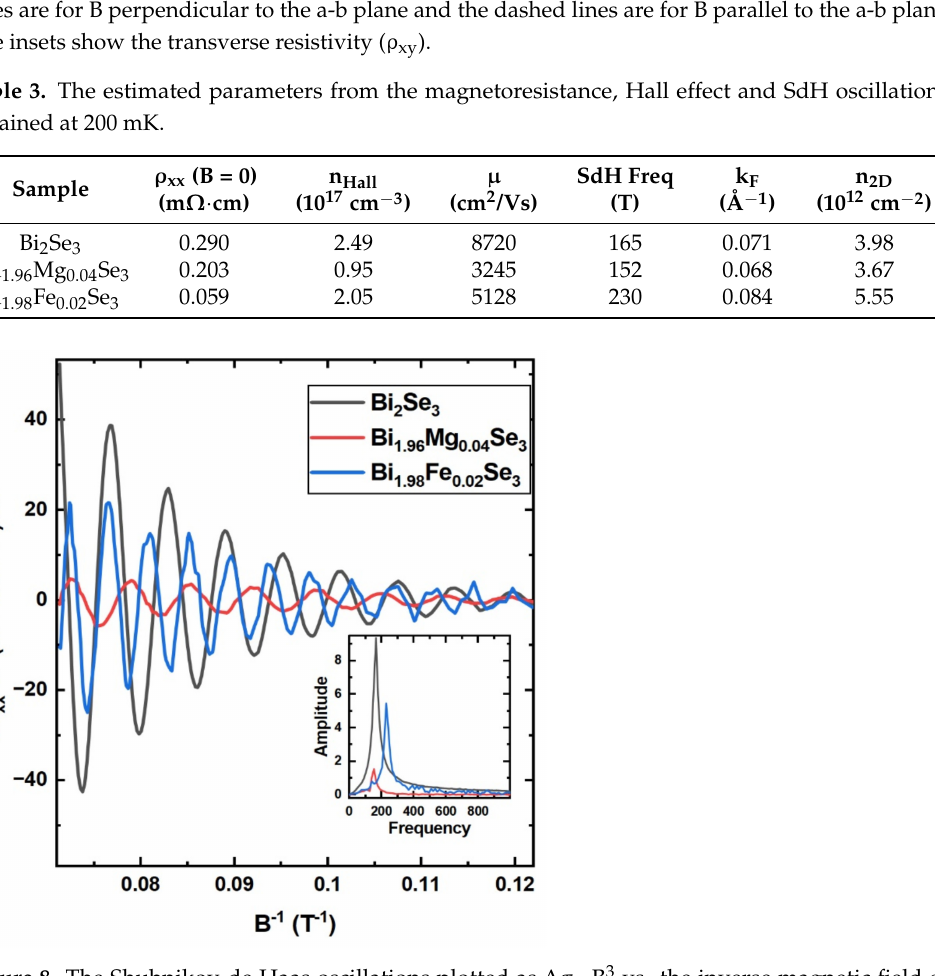
Figure 8. The Shubnikov-de Haas oscillations plotted as ∆ σ xx B 3 vs. the inverse magnetic field of Bi 2 Se 3 , Bi 1.96 Mg 0.04 Se 3 and Bi 1.98 Fe 0.02 Se 3 at 200 mK. The inset shows the spectral intensity of the SdH